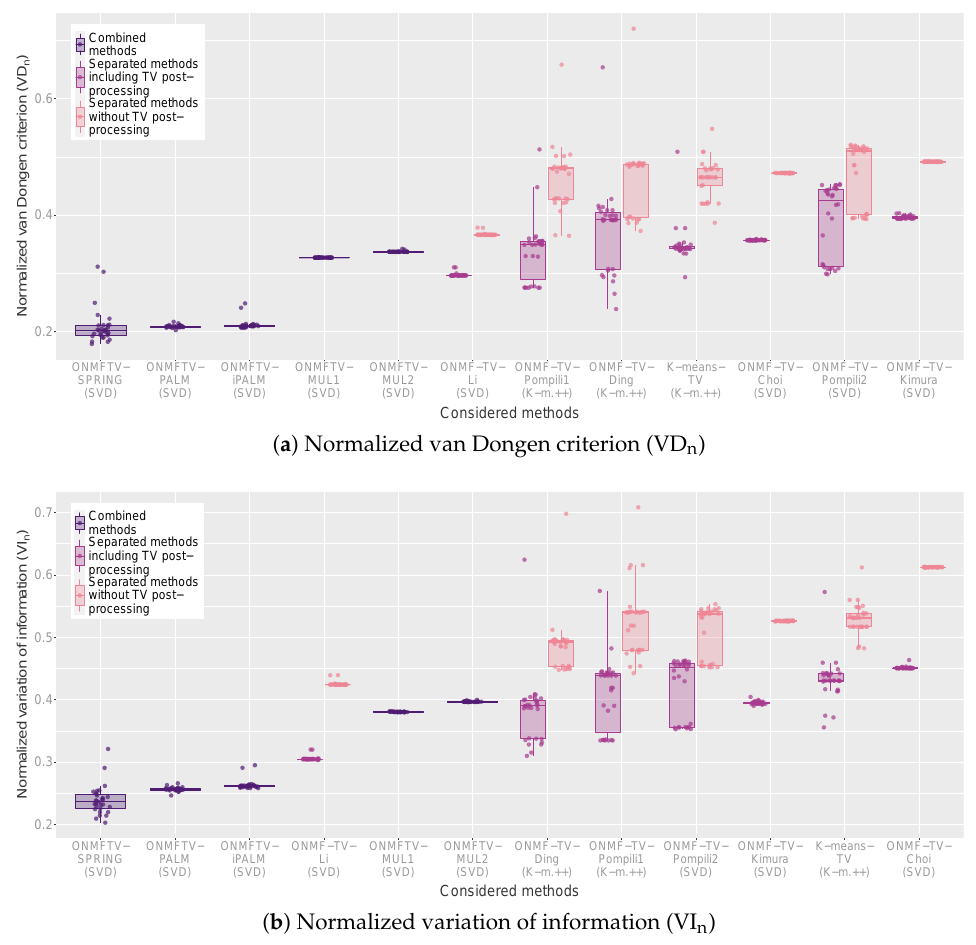
Figure 4. Box plots of the normalized van Dongen criterion (VD n ) and the normalized variation of information (VI n ) of all performed experiments.